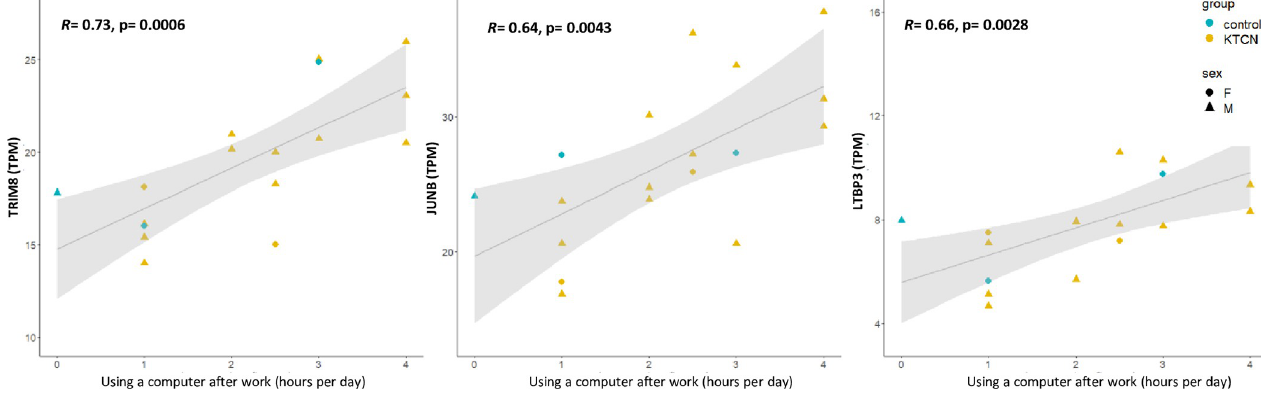
Fig 5. Results of Pearson’s correlation. Pearson’s correlation results between the expression of selected genes, TRIM8 , JUNB , and LTBP3 (in TPM), in the cone (central) region of corneal epithelium and time spent using a computer after work. Values of regression and statistical significance are presented in plots.